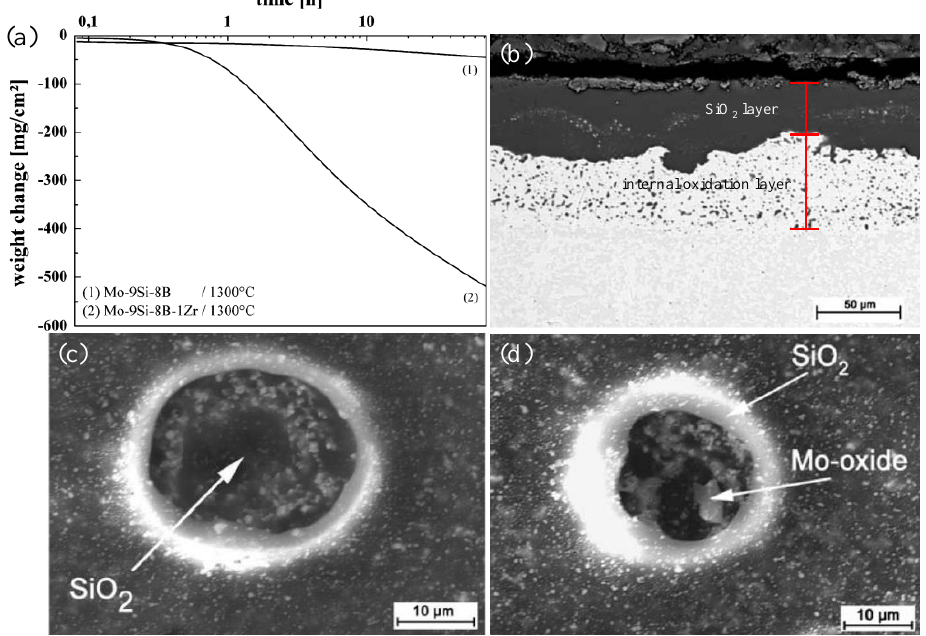
Figure 10. ( a ) Weight change curve of both samples at 1300 °C; ( b ) Cross-sectional SE image of Mo – 9Si – 8B sample after oxidation 72 h at 1300 °C; ( c , d ) SE images of Mo – 9Si – 8B – Zr sample surface after oxidation 15 min at 1300 °C. Reproduced with permission [55]. Copyright 2009 Springer Nature.